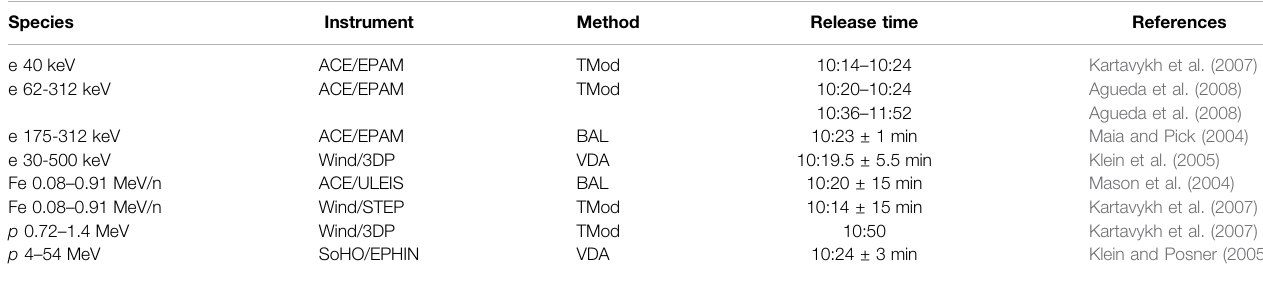
TABLE 1 | Particle release times in the May 1, 2000 ent (with 500 s added to allow for comparison with electromagnetic observations from 1 AU). Species